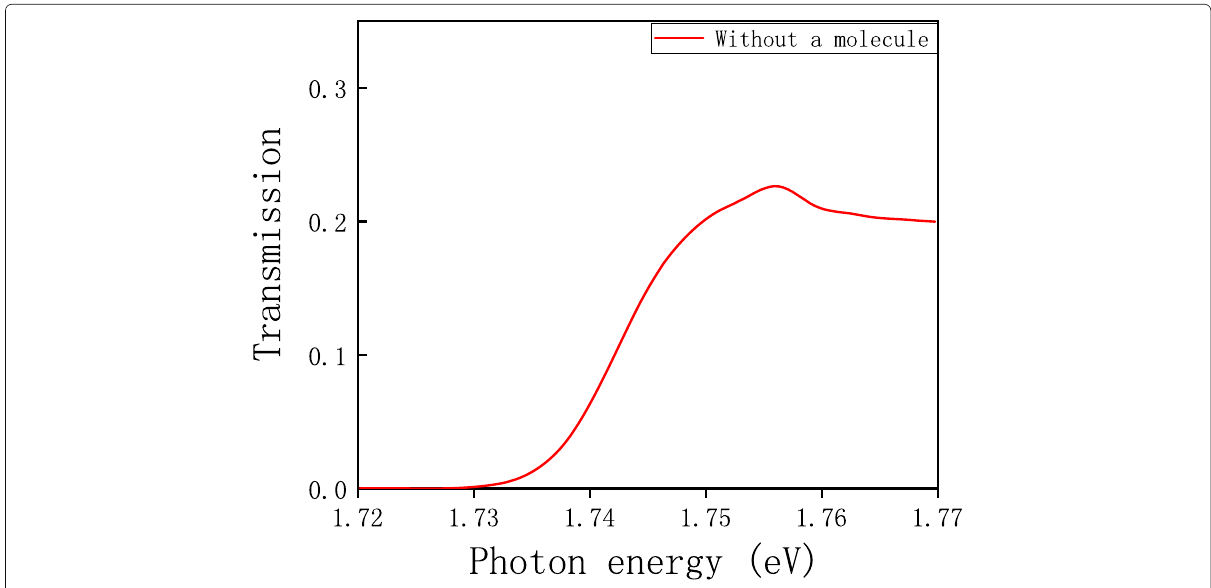
Fig. 2 The transmission spectrum of the structure without a